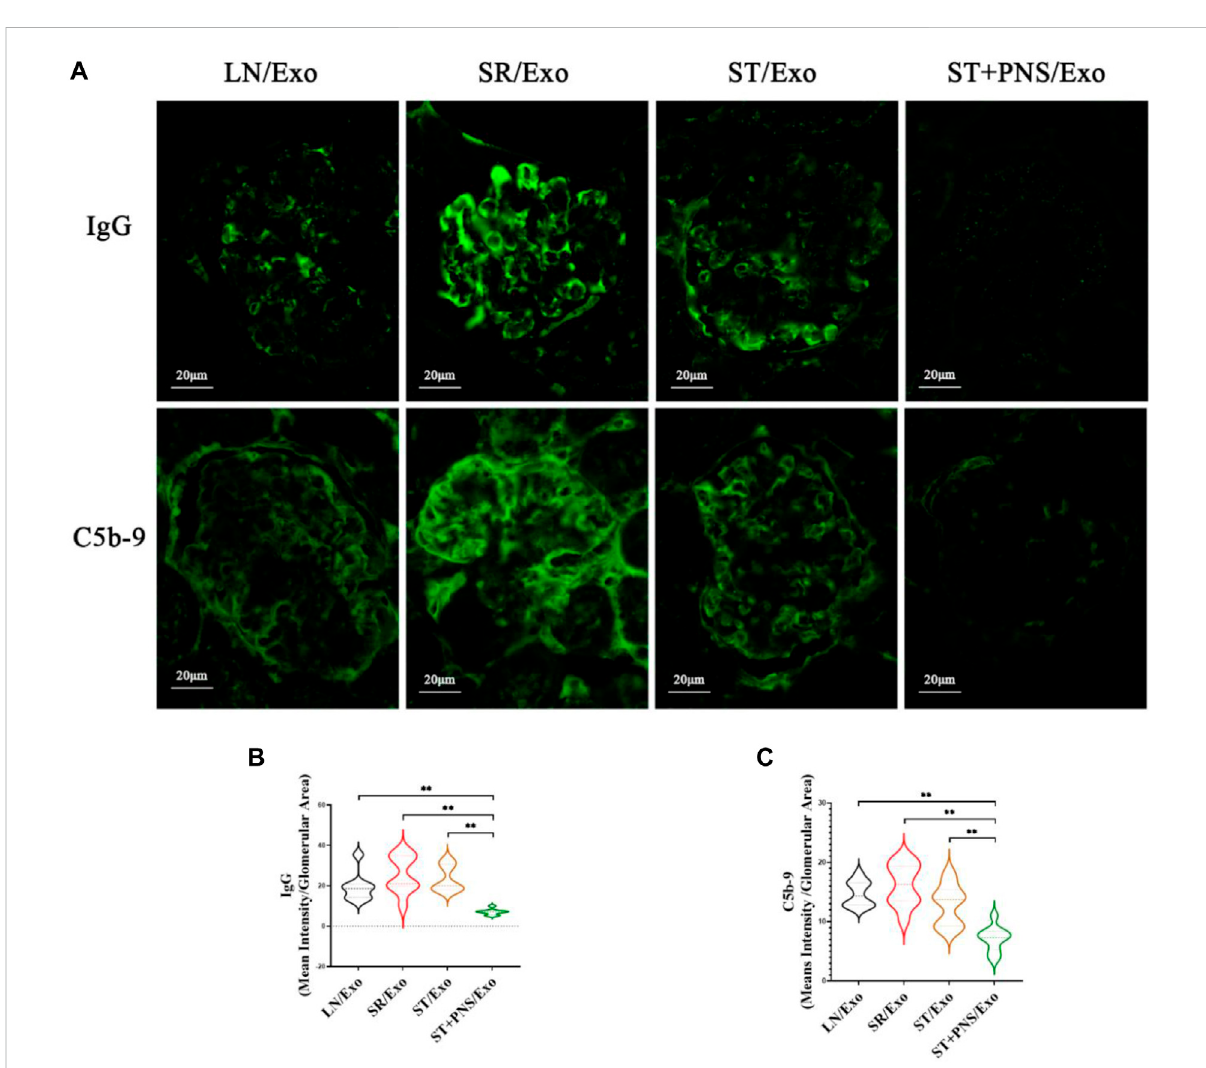
FIGURE 7 Effects of different exosome interventions on IgG and C5b-9 deposition in glomerular capillary collaterals of LN mice. (A) Glomerular IgG and C5b-9 expression in each group detected by Immuno fl uorescence staining of renal tissues (scale bar 20 μ m). (B,C) Quantitative analysis of glomerular IgG and C5b-9 fl uorescence intensity in each group (ImageJ software). All data are expressed as the mean ± standard deviation of independent groups, *p < 0.05, **p <